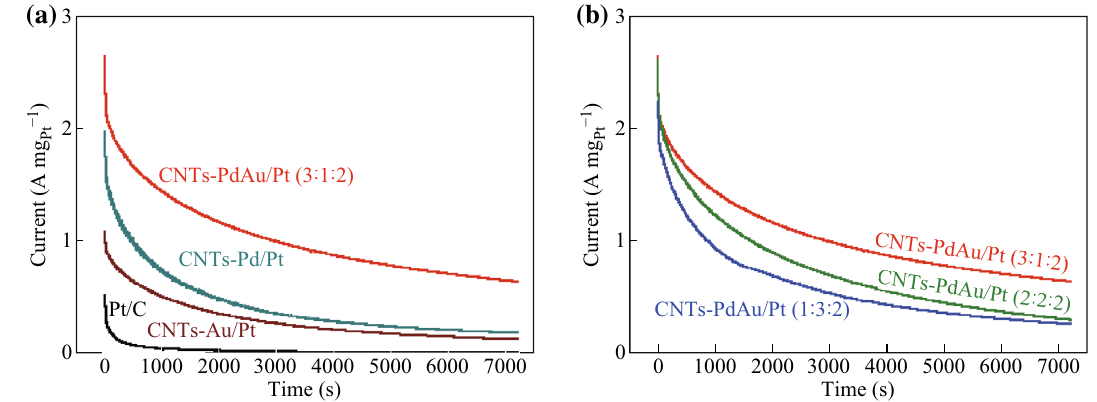
Fig. 8 CA curves for the MOR (–0.2 V vs. Ag/AgCl in 1 M CH 3 OH ? 1 M KOH) using: a CNTs-PdAu/Pt (3:1:2) NPs, Pd/Pt, and Au/Pt bimetallic NPs, and a commercial Pt/C catalyst, and b MWCNTs-supported PdAu/Pt trimetallic NPs with different Pd/Au/Pt